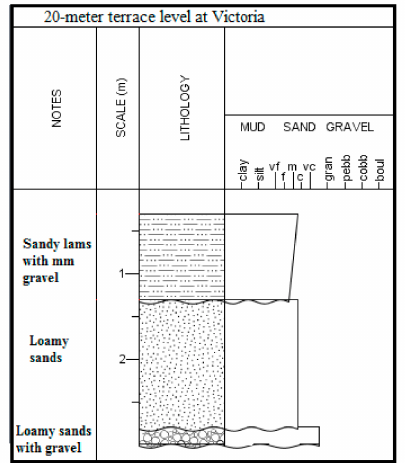
Figure 8. Sediment log of drilling core at the 20 m terrace level at Victoria.